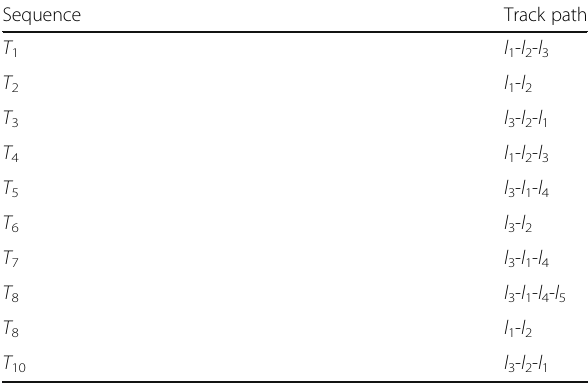
check-in times exceeds 200, the sensitivity level is the Table 1 The trajectory sequences of the user u